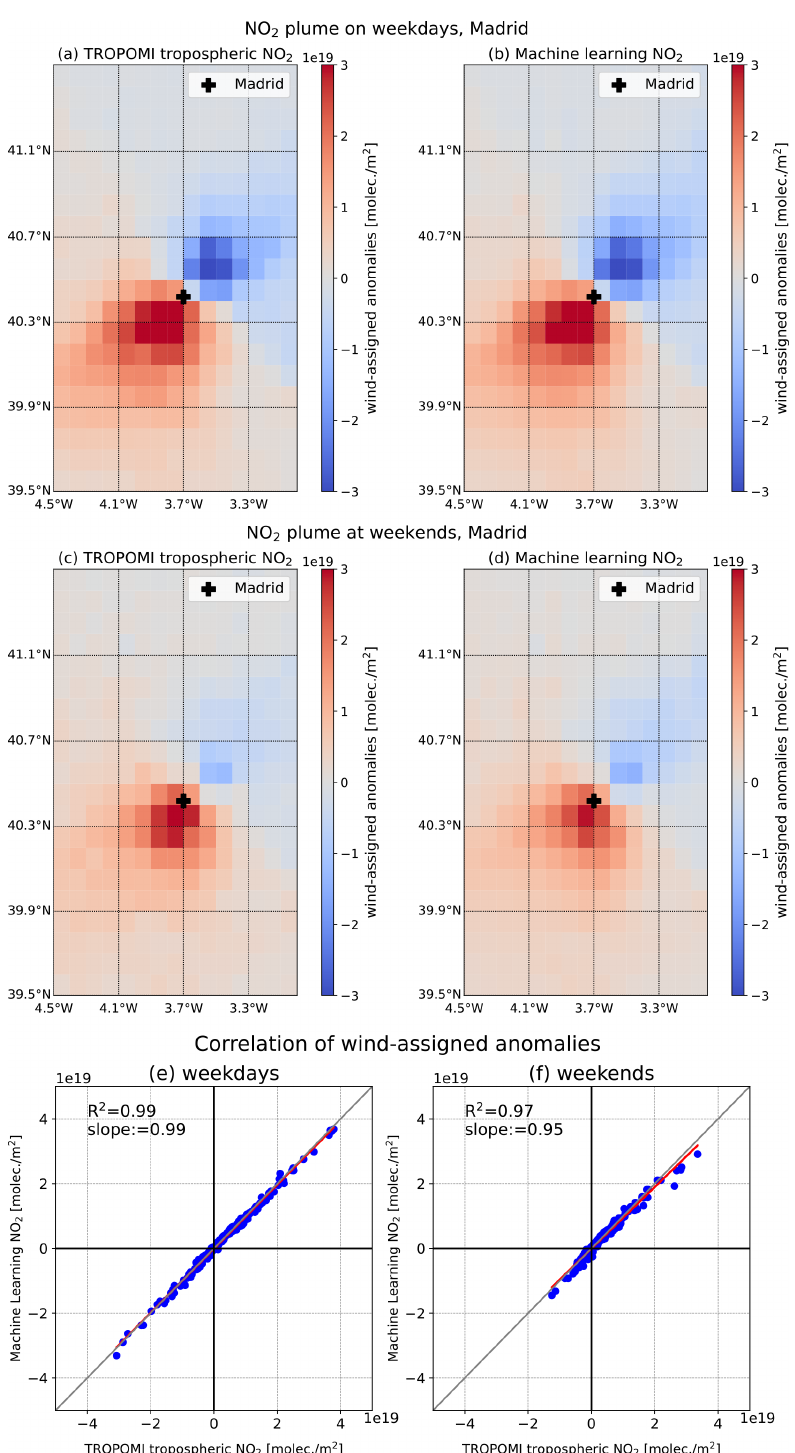
Figure A11. Wind-assigned plumes derived from TROPOMI observations (a, c) , the ML method (b, d) , and their correlation plots (e, f) on weekdays (a, b, e) and weekends (c, d, f) in